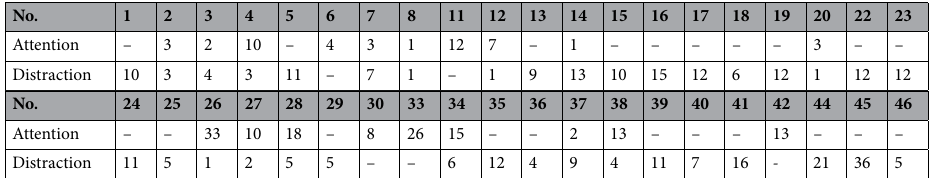
Table 1. Number of attention and distraction instances per debate in the dataset. The ’No.’ column represents the debate ID, ’Attention’ represents the number of attention instances and ’Distracted’ represents the number of distraction instances present in the particular debate. ’–’ denotes that no said instances were found where the majority of annotators agreed. If a debate ID is missing from ’No.’, it indicates that there were no labeled instances of attention or distraction in that debate.